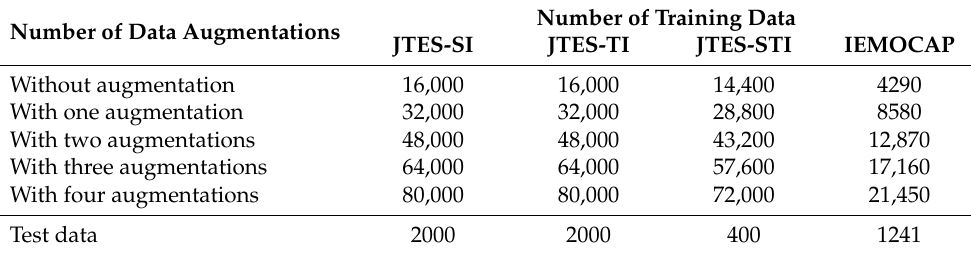
Table 1. Number of data (utterances) in each number of data